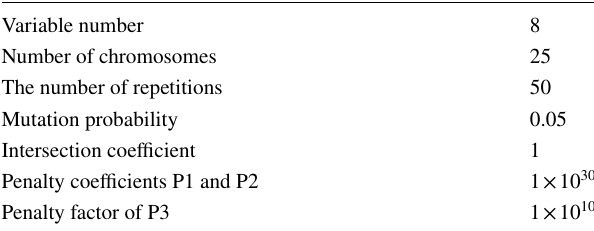
Table 2 NSGA-II parameters used for optimal design of two-loop no-